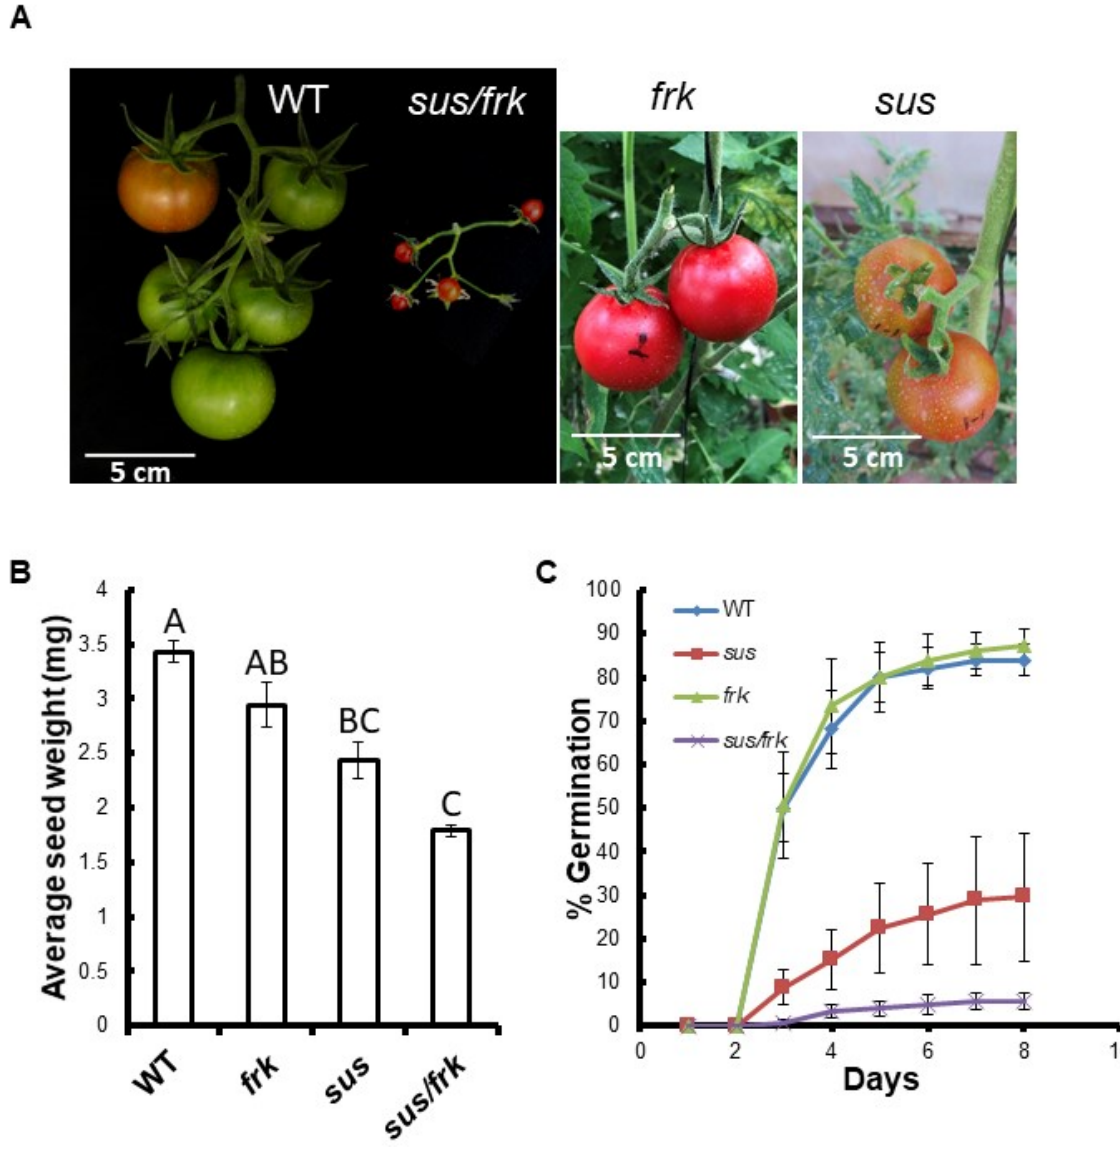
Figure 4. sus / frk plants have small fruits and small seeds with reduced germination rates. ( A ) From left to right: WT fruits, sus / frk fruits, frk fruits, and sus fruits. ( B ) Average seed weights for the WT, frk , sus and sus / frk ( n = 3 × 50). ( C ) Germination rates of WT, sus , frk and sus / frk seeds ( n ≥ 4 × 25). Error bars indicate the standard error. Different letters indicate a significant difference ( t -test, p < 0.01).